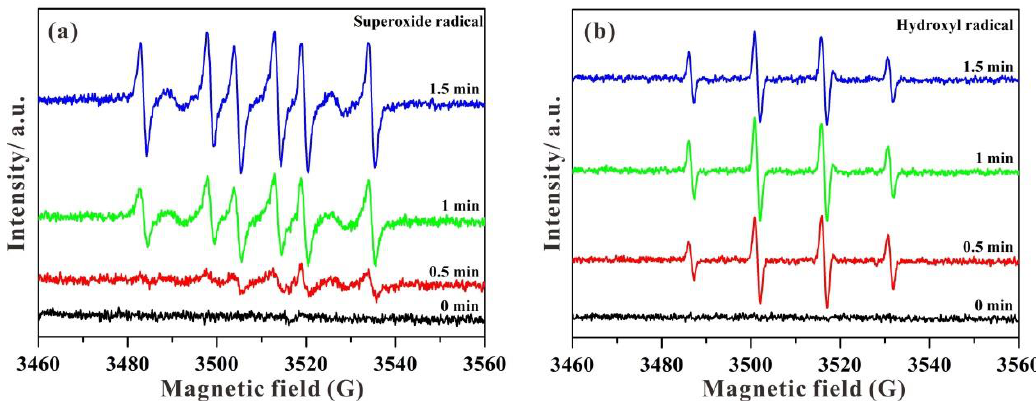
Figure 10. ESR spectra of STNT3 in aqueous solution before and after visible light irradiation: ( a ) DMPO-•O 2− and ( b ) DMPO-•OH.